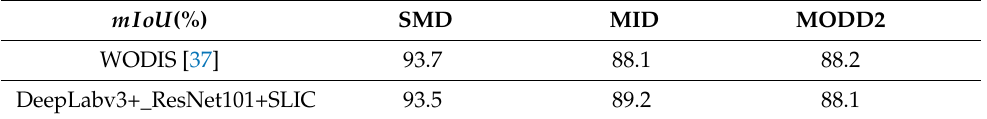
Table 3. Comparison of mIoU between the WODIS [37] and our DeepLabv3+_ResNet101+SLIC on the SMD, MID and MODD2 validation